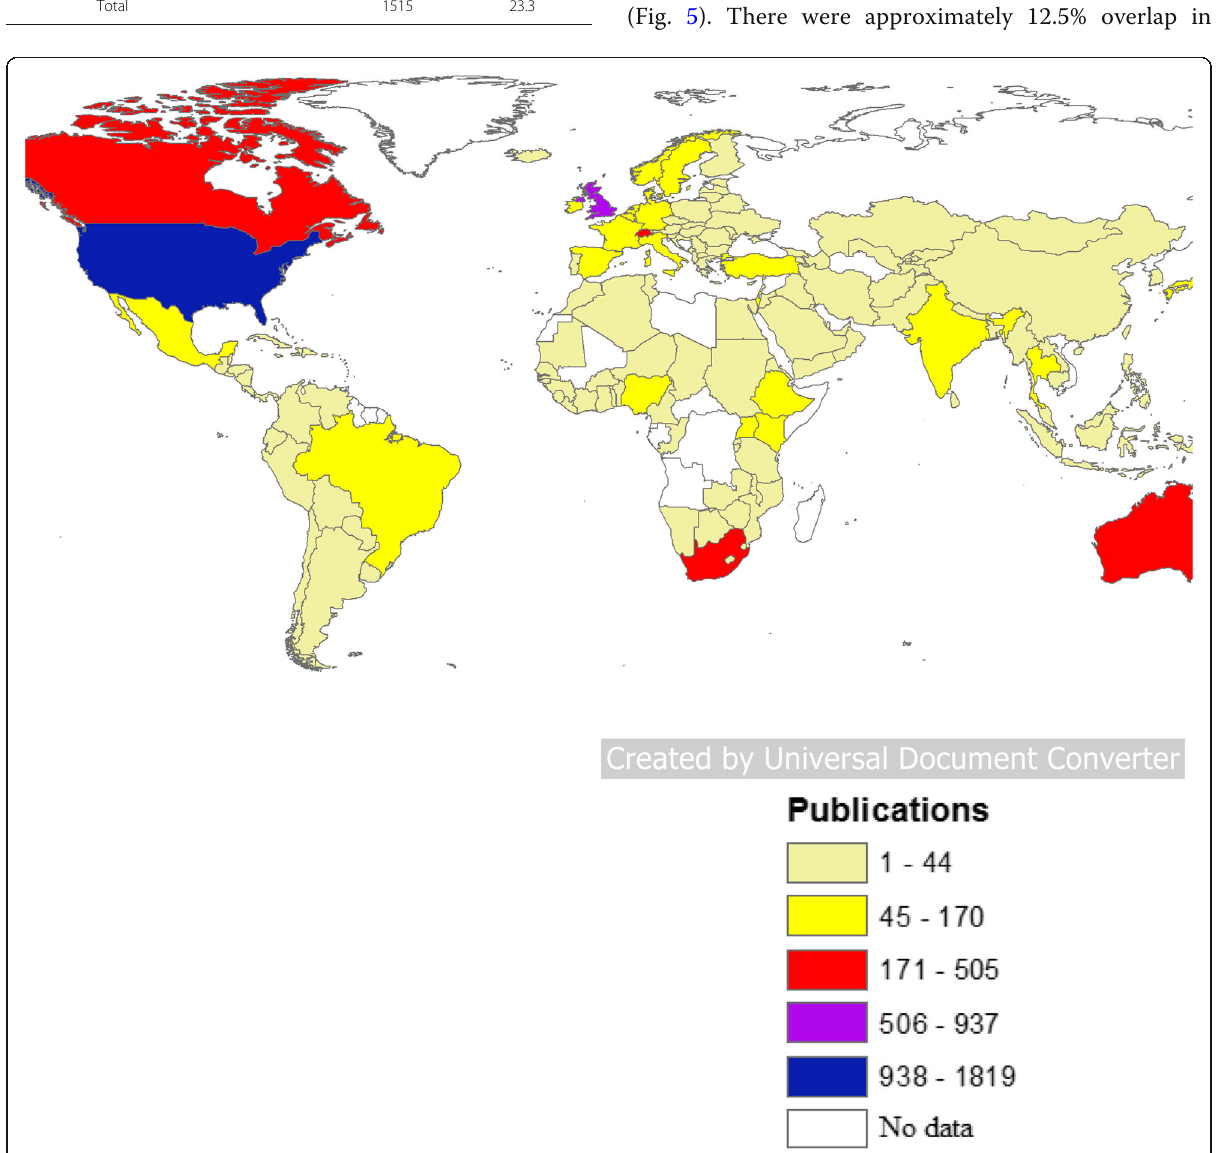
Fig. 3 Geographical distribution of publications on HHR (1900 – 2017). The color coding is as follows: